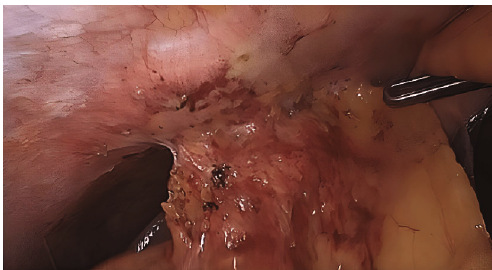
Figure 2: Intraoperative fi nding: chronic in fl ammation of the gallbladder to the abdominal wall.